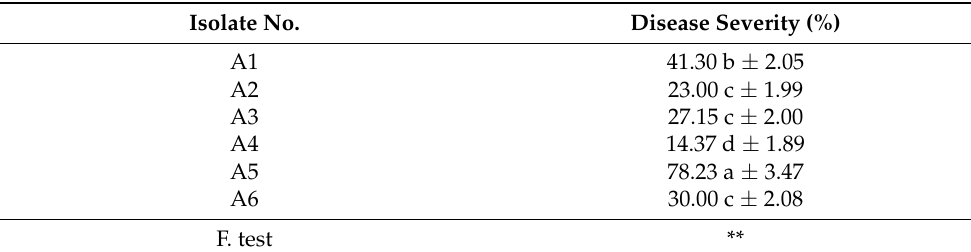
Table 2. Disease severity percentage as the pathogenicity of 6 isolates of Alternaria alternata on common bean plants under greenhouse conditions, 21 days after inoculation.